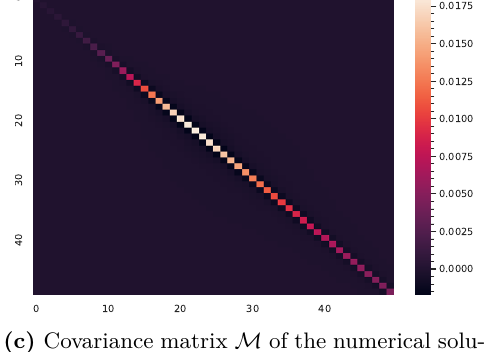
(c) Covariance matrix M of the numerical solu- tion of eq. (1.4) in the case of piecewise linear in- terpolation.